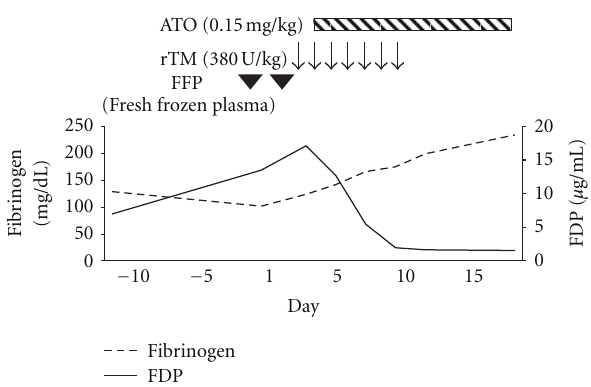
Figure 1: Clinical course of disseminated intravascular coagulation (DIC). The patient was admitted on day 1. The administration of recombinant thrombomodulin (rTM) was started on day 4, and then the administration of arsenic trioxide (ATO) was started on day 5. Fibrin/fibrinogen degradation product (FDP) levels decreased immediately, and fibrinogen levels gradually increased, indicating DIC was